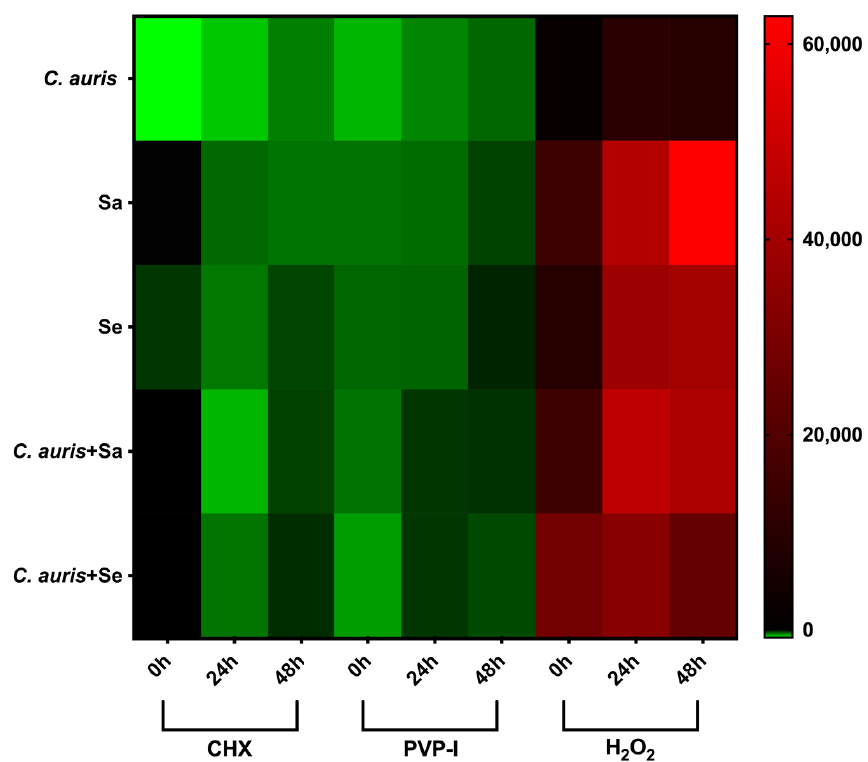
control of the same biofilm.